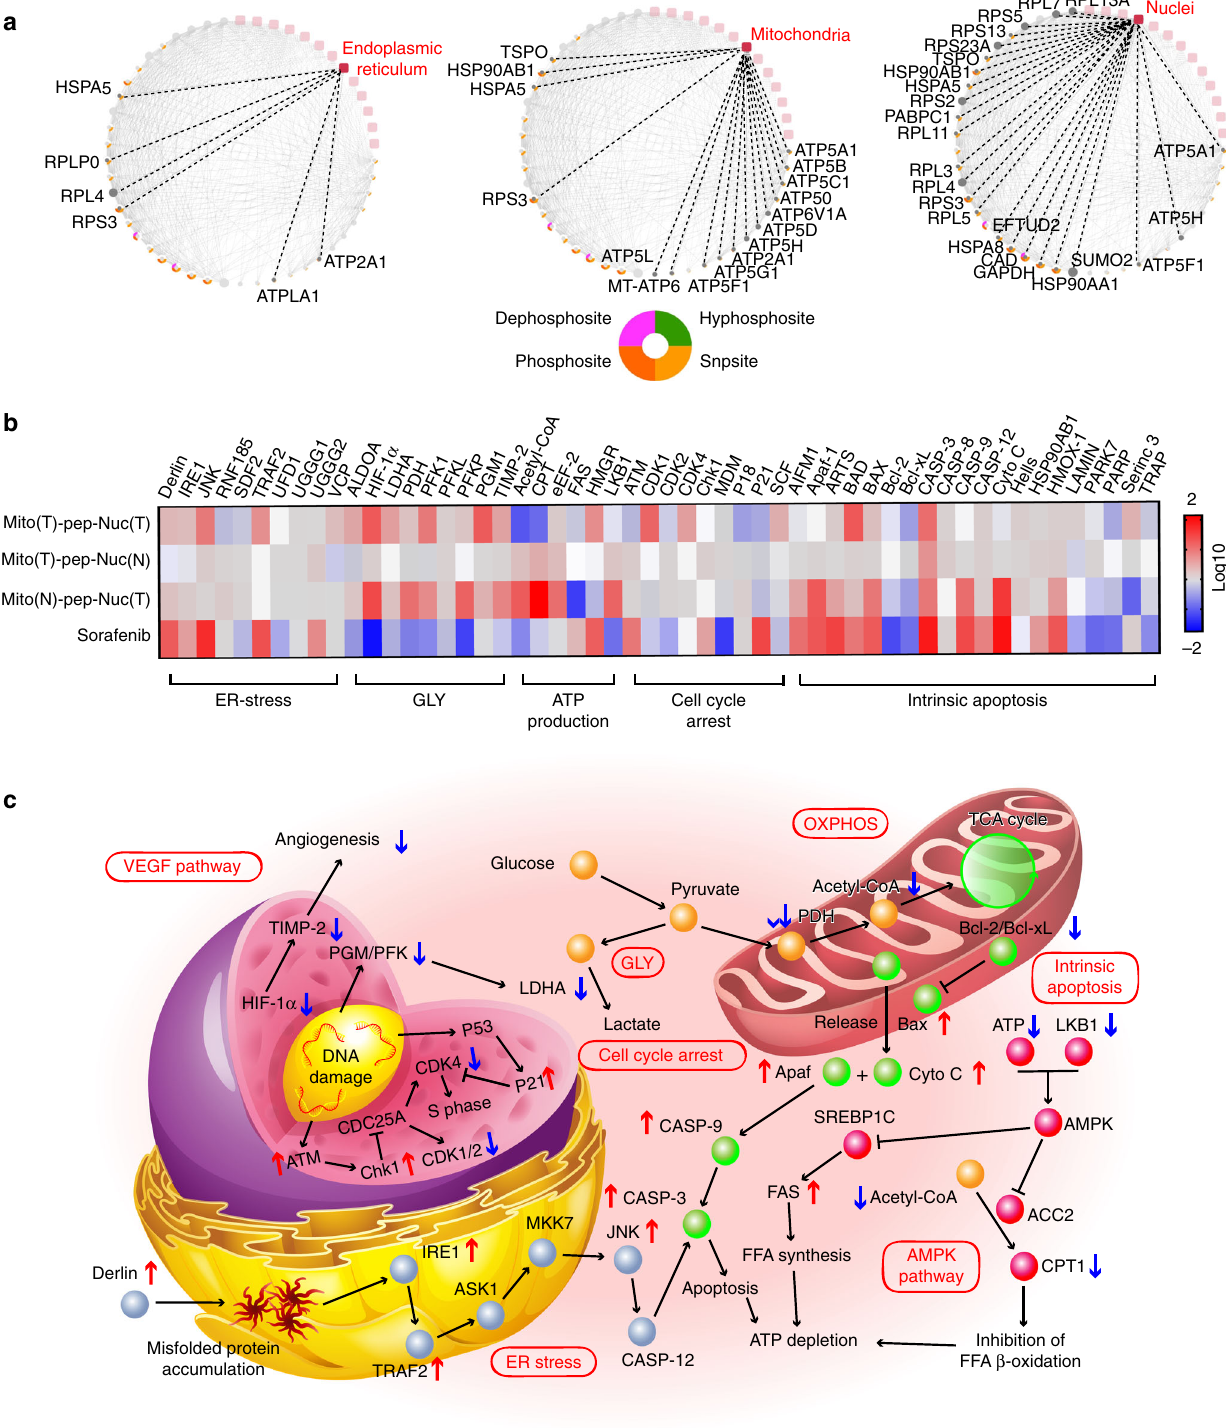
Fig. 8 Proteome study. a Networks showing the corresponding down-regulated proteins identi fi ed by LC/MS that interact with three different organelles, including endoplasmic reticulum, mitochondria, and nuclei. Potential form of phosphorylation of each protein is shown below. b A heat map showing the enriched proteins that were associated with fi ve classes of functions: ER stress, GLY, ATP production, cell cycle arrest, and intrinsic apoptosis. The bioinformatic analysis was conducted using Omicsbean Cancer software. A color bar on the right indicates the color scales. c A schematic illustrating the network of possible pathways underlying the therapeutic effect of Mito(T)-pep-Nuc(T) in cancer